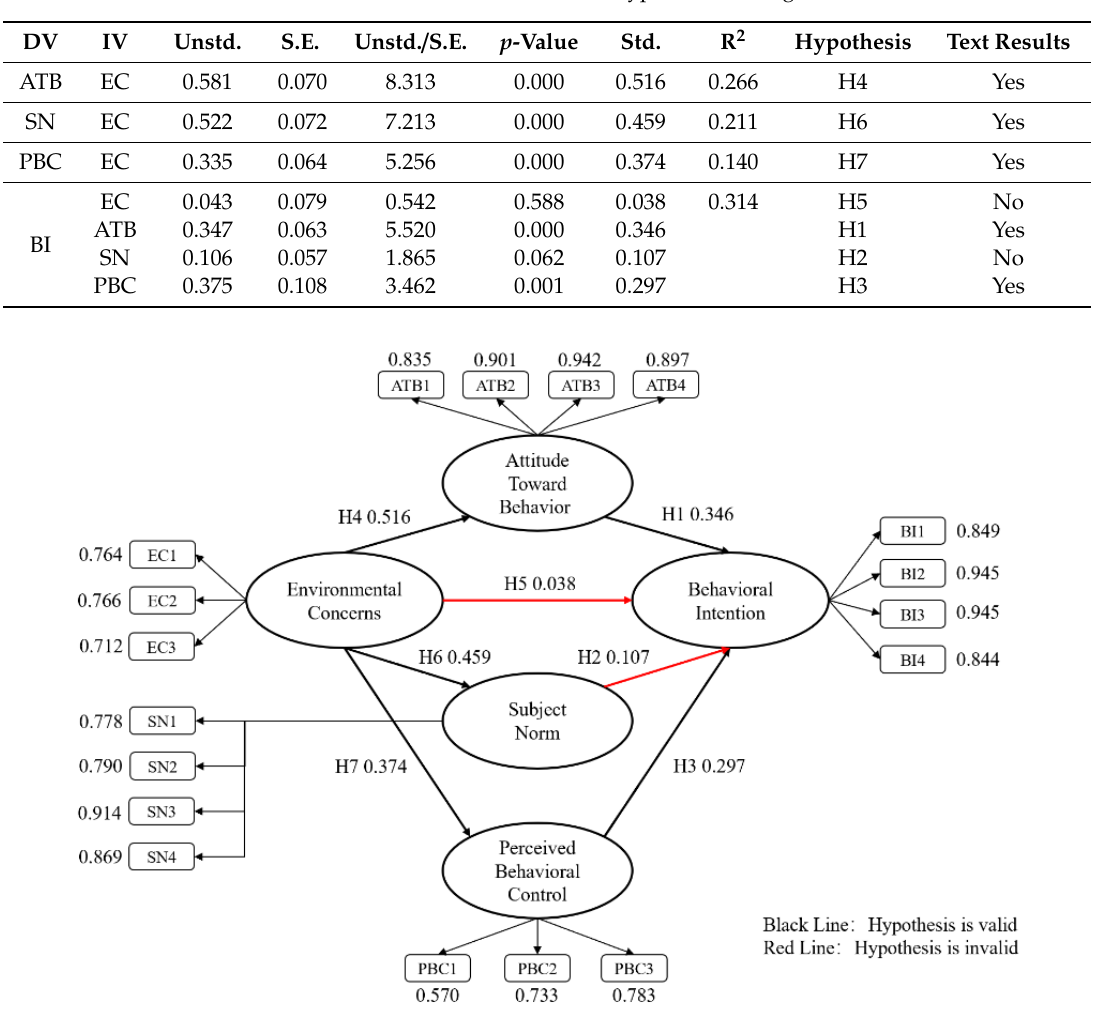
Table 7. Results of the SEM and hypothesis testing.